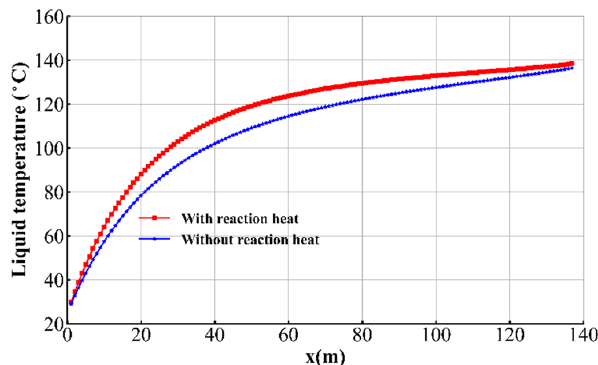
Figure 3. Temperature distribution of the fluid in the fracture (blue line: without reaction heat; red line: considering reaction heat).